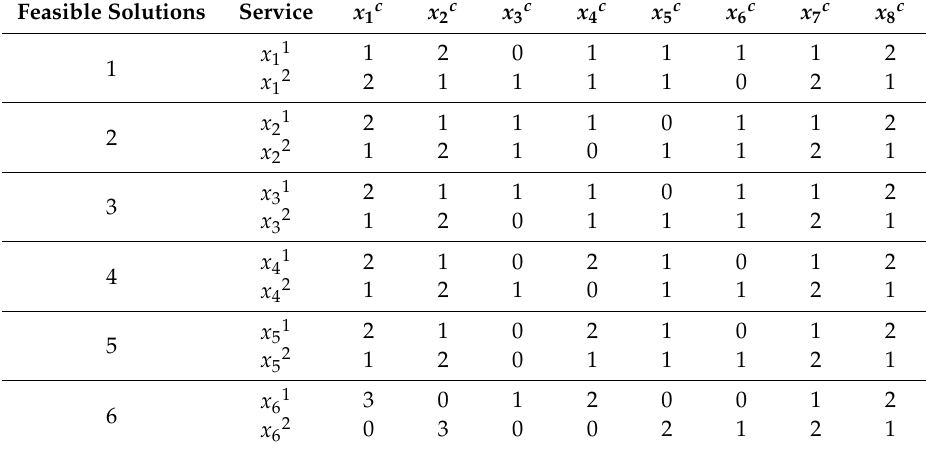
Table 20. Feasible